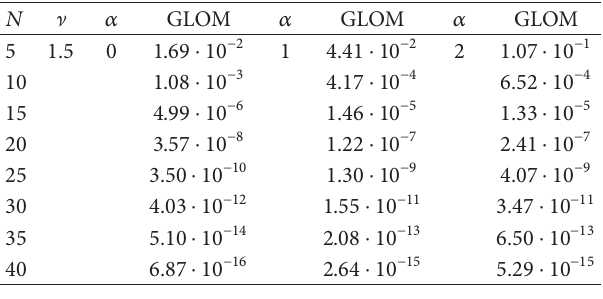
Table 4: Maximum absolute error for various choices of 𝛼 and 𝑁 for Example 5.